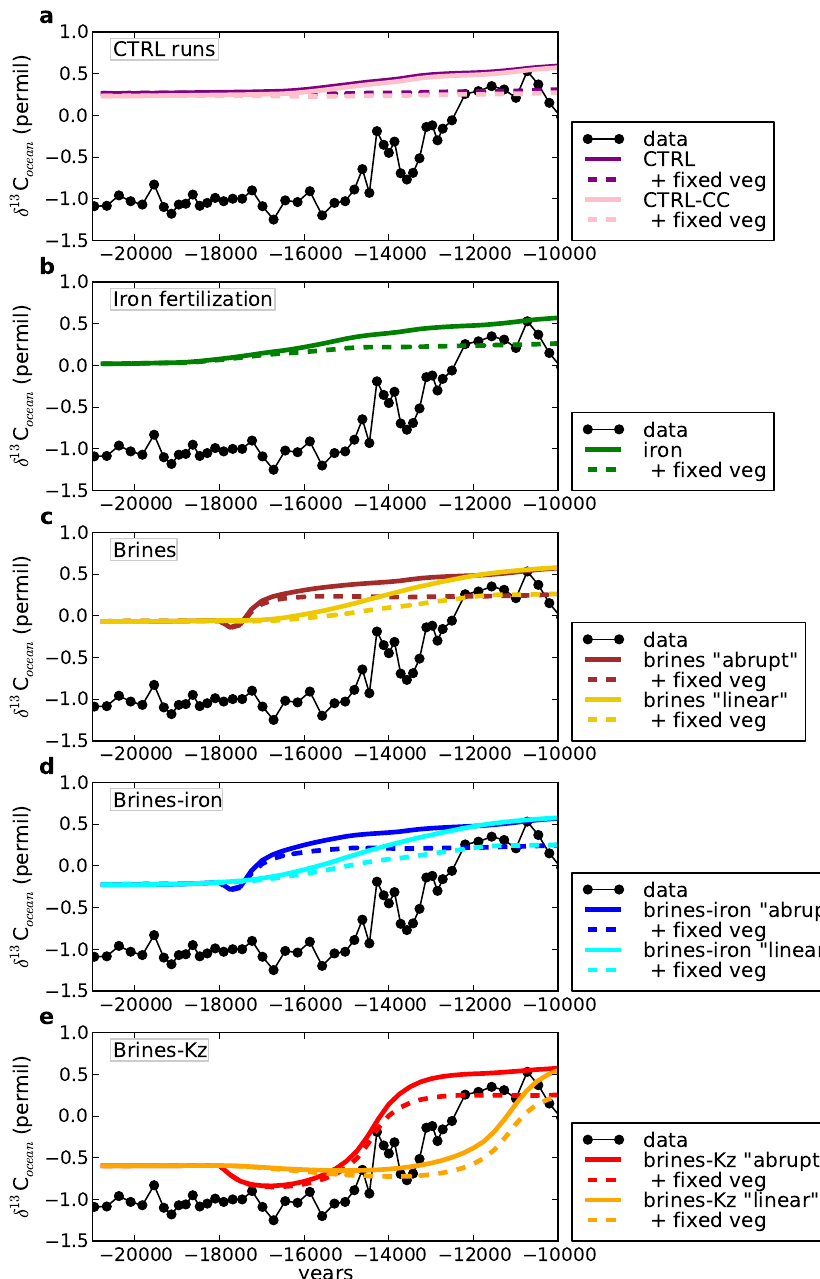
Fig. 10. Evolution of deep Southern Ocean δ 13 C during the last deglaciation with different oceanic mechanisms and comparison with data: (a) control (CTRL) runs without and with carbonate compensation (CC), all other simulations are with carbonate compensation, (b) simulations with iron fertilization, (c) simulations with the sinking of brines (two scenarios as defined in Fig. 6), (d) simulations with the sinking of brines (two scenarios as defined in Fig. 6) and iron fertilization, (e) simulations with the sinking of brines (two scenarios as defined in Fig. 6) and interactive vertical diffusion coefficient ( K z ). Each simulation has either an interactive vegetation or a fixed glacial vegetation (“fixed veg”). The data are from Waelbroeck et al.